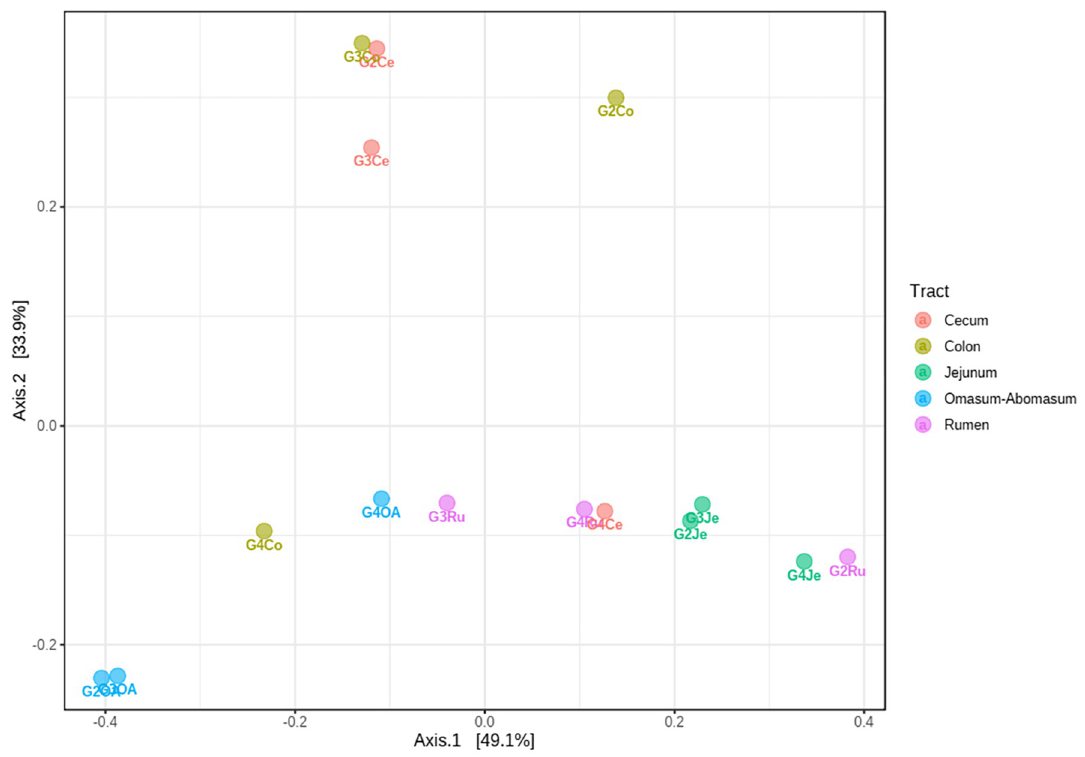
Fig 6. Comparison of the archaeal diversity present in the Capra hircus GITs. The differences between samples were based on the relative abundance of OTUs. Ru: rumen; OA: omasum + abomasum; Je: jejunum; Ce: cecum; Co: colon; G: